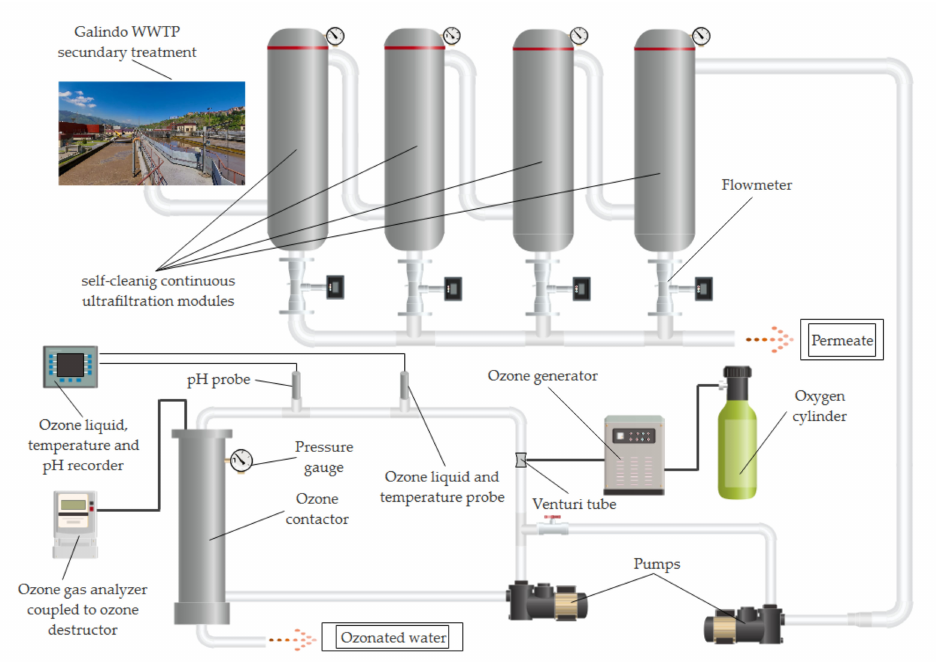
Figure 2. Diagram of the continuous ultrafiltration process coupled to the ozonation system for the treatment of the reject